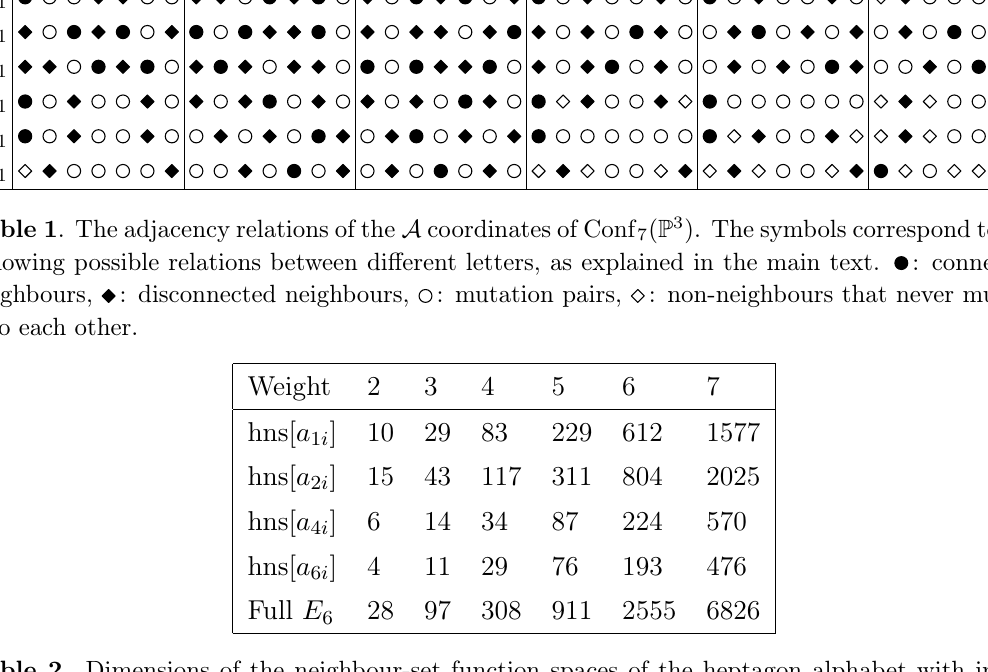
Table 2 . Dimensions of the neighbour-set function spaces of the heptagon alphabet with initial entries a 1 i and the dimensions of the full cluster-adjacent heptagon